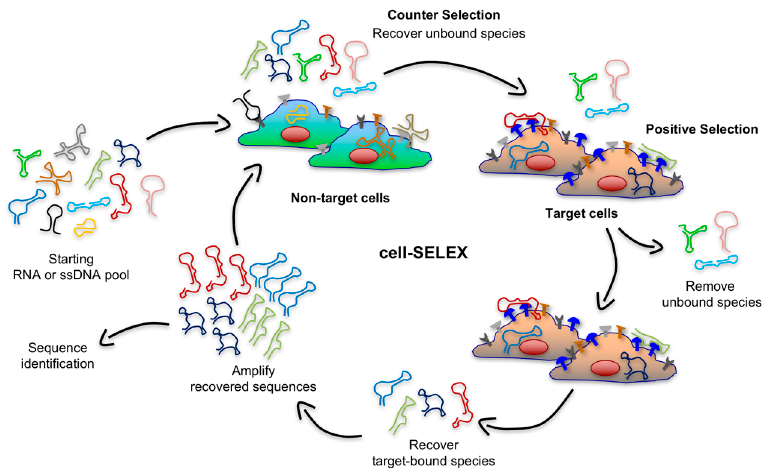
Figure 3. Schematic illustration of the cell-SELEX. This procedure consists of four main steps for each round of selection: (i) counter-selection by incubating the nucleic acid library with negative cells (green cells) that do not express target antigens, (ii) a positive selection by incubating recovered unbound sequences with positive cells (tan cells) expressing cell-surface antigens (depicted in blue), (iii) recovery of target-bound sequences, and finally (iv) re-amplification of recovered species.